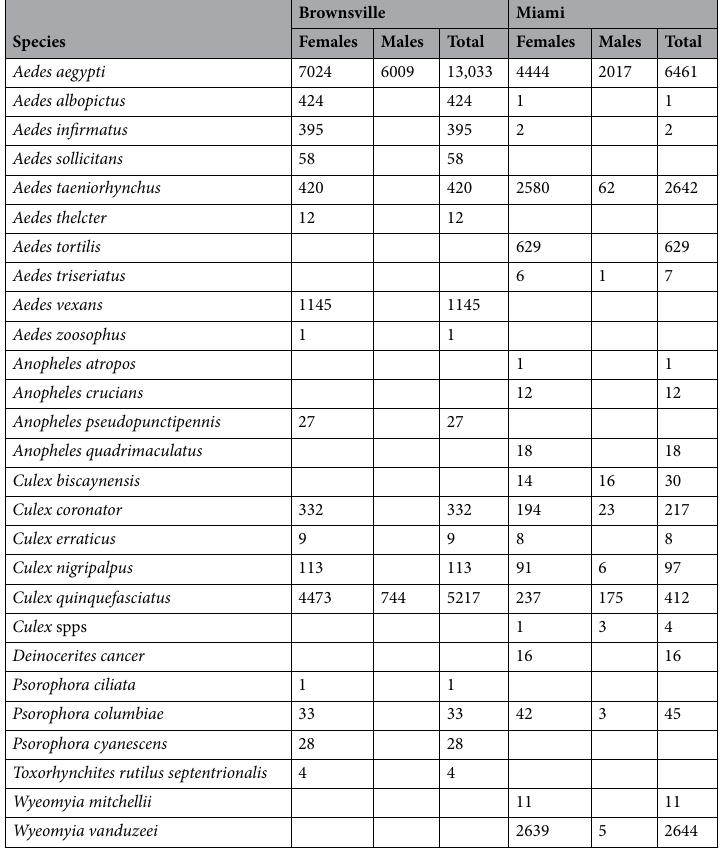
Table 1. Mosquito species captured by using BG-Sentinel 2 traps during Aedes aegypti activity pattern studies in Brownsville, Texas and Miami, Florida in